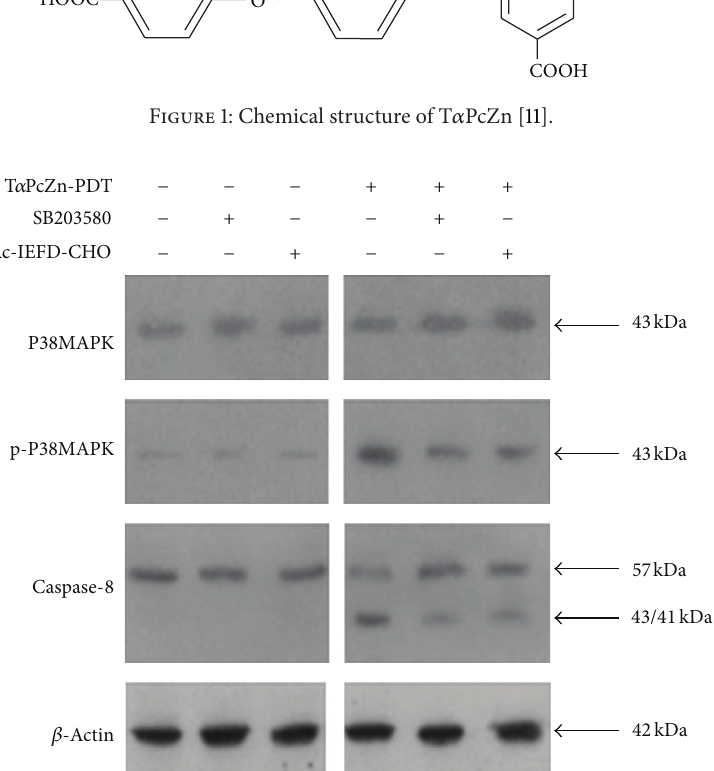
Figure 2: Effect of T 𝛼 PcZn-PDT on P38MAPK, p-P38MAPK, and Caspase-8, respectively, without or with SB203580 or Ac-IEFD-CHO in T 𝛼 PcZn-PDT-induced apoptosis of Bel-7402 cells analyzed by immunoblot assay. Bel-7402 cells were pretreated with T 𝛼 PcZn (54 𝜇 M) in incubated for 3 h. Expression of P38MAPK, p-P38MAPK, and Caspase-8 was analyzed by immunoblot